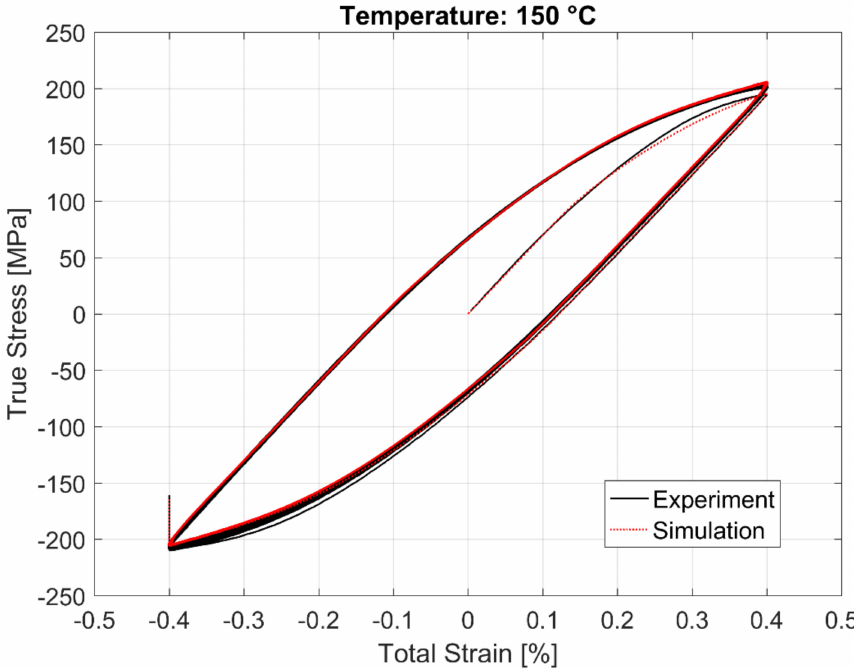
Figure 21. Experimental vs. visco-plastic model prediction at 150 ◦